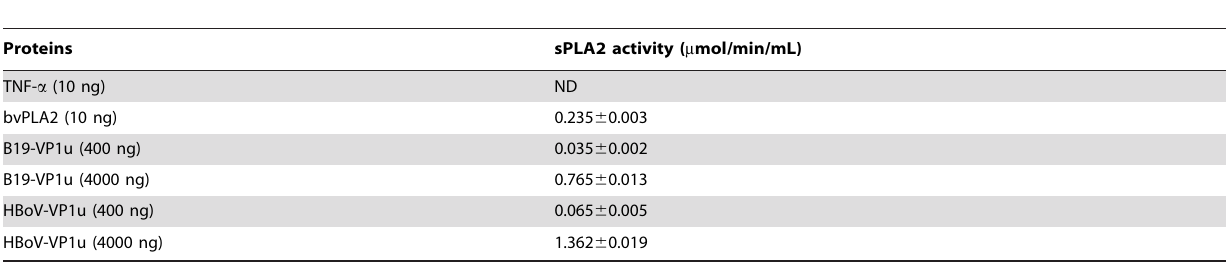
Table 1. Secreted phospholipase A2 (sPLA2) activity of recombinant B19-VP1u or HBoV-VP1u proteins.